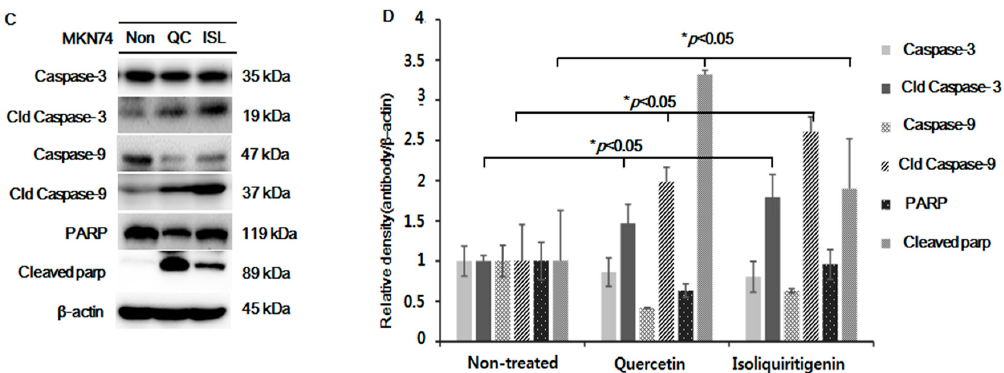
Figure 5. Expressions of p53, p21, Bax, PUMA, (cleaved) caspase-3, -9 and (cleaved) Parp proteins in tumor tissues from mice implanted with EBV( − ) human gastric carcinoma (MKN74) EBV( − ) tumor tissue was excised from each animal and prepared for western blot analysis. The protein expressions of ( A ) p53, p21; ( B ) Bax, PUMA; ( C , D ) (Cleaved) caspase-3, -9, and Parp were identified and relative intensities were measured. β -Actin was used as the loading control.